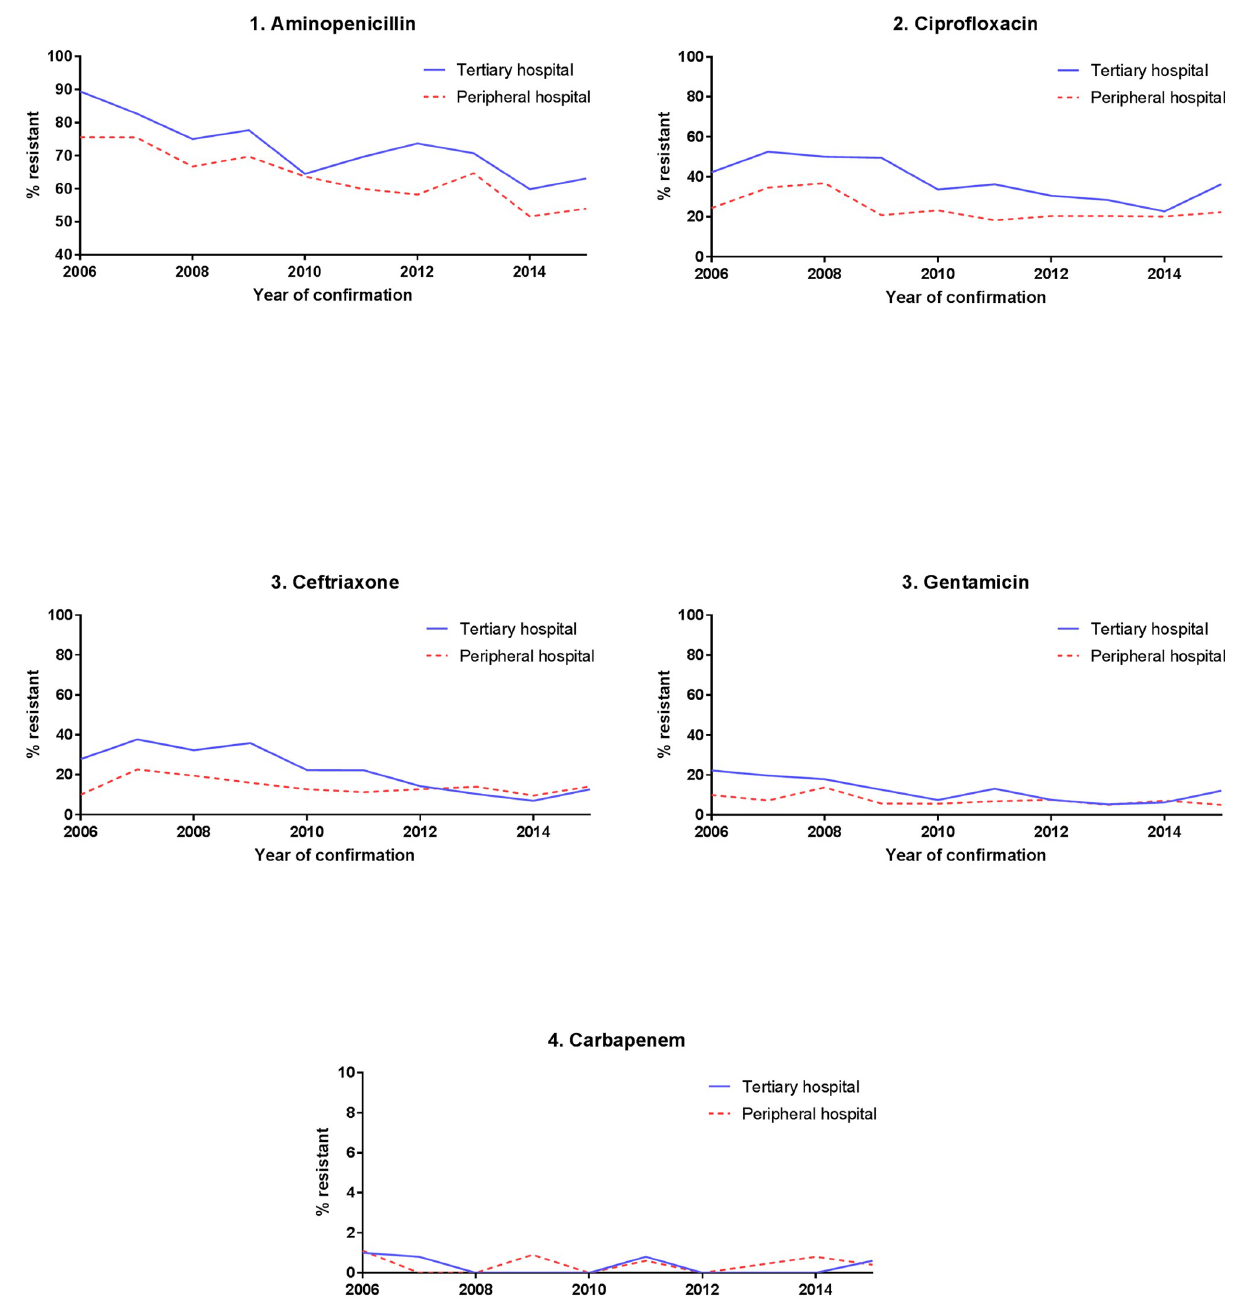
Fig 2. Proportion of antibiotic resistant of E.coli strains over time by hospital